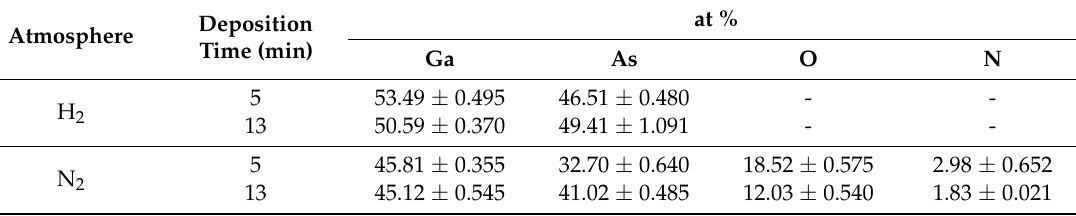
Table 2. Atomic percentage of GaAs films obtained by closed-spaced vapor transport (CSVT) technique. Atmosphere